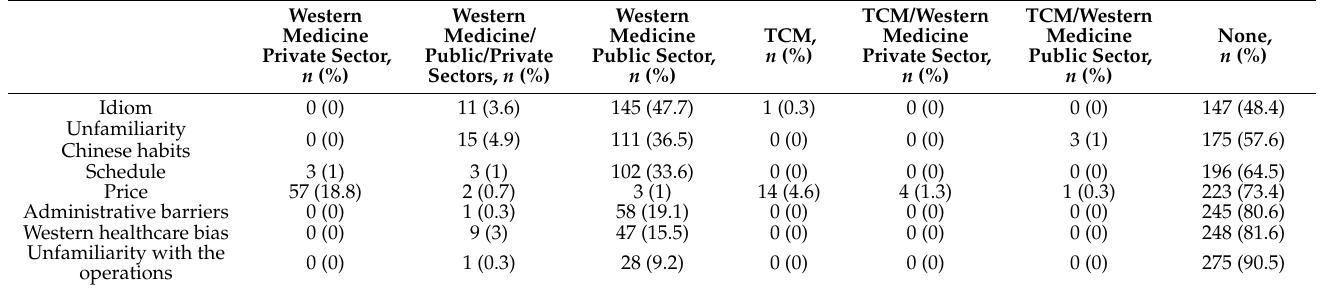
Table 2. Barriers to accessing healthcare in Portugal pointed out by Chinese immigrants ( n =